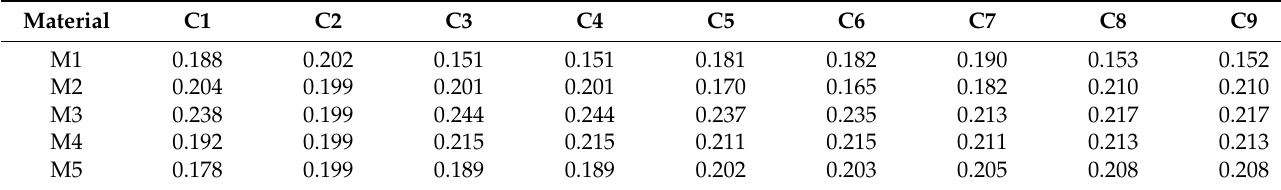
Table 14. Normalized COPRAS decision